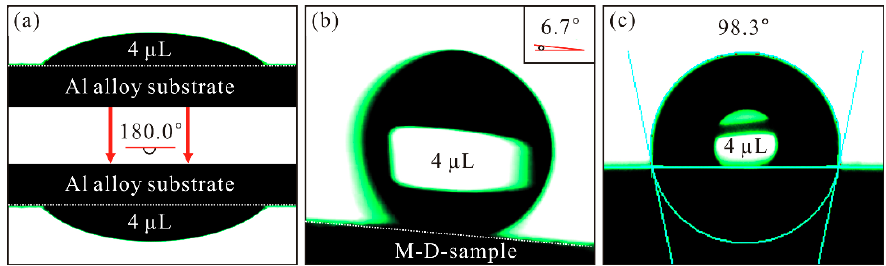
Figure 4. Sliding angles of ( a ) Al alloy substrate and ( b ) modified deposited sample (M-D-sample). ( c ) Water contact angles of modified substrate.